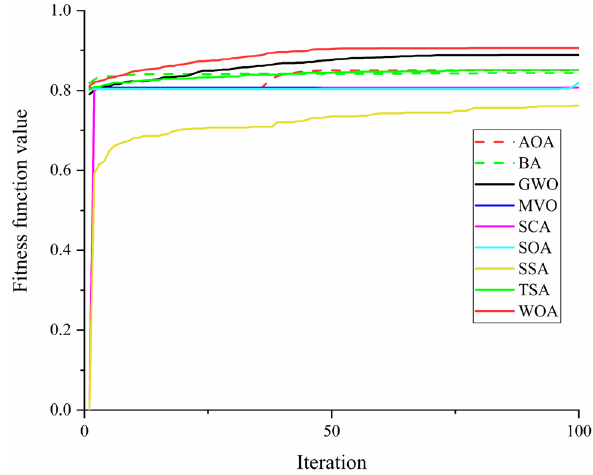
Fig. 8 The evolution curves of the algorithms for case